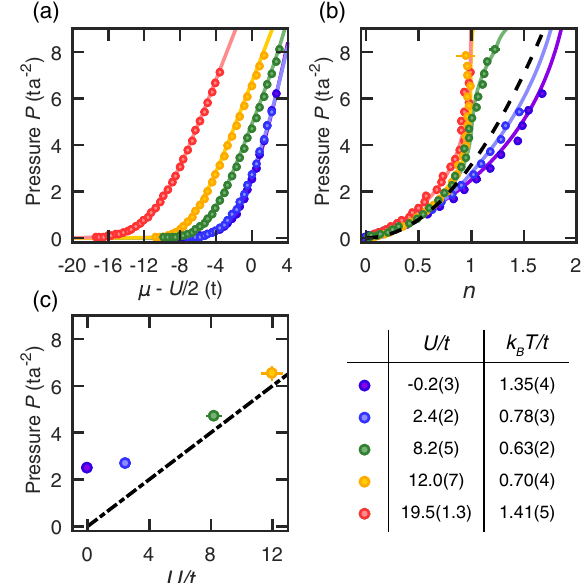
FIG. 1. Pressure as a function of interaction strength and temperature. (a) Pressure versus chemical potential for different interaction strengths and temperatures. The uncertainties of the pressure and the chemical potential are smaller or equal to the marker size. (b) Pressure versus filling for the same interactions and the same temperatures as in (a). Horizontal error bars display the standard error obtained from averaging the density data over regions of constant chemical potential. The solid lines in (a) and (b) are the predictions from NLCE data [21] with the exception of the purple solid line, which represents the ideal Fermi gas on a lattice; the black, dashed line in (b) is the T ¼ 0 prediction of the free Fermi gas using the effective mass at the bottom of the lowest band. (c) Pressure at half filling n ¼ 1 versus interaction strength. The horizontal error bars display the systematic uncertainties of U=t , the vertical error bars indicate the uncertainty of determining half filling from the density profiles n ð μ Þ . The dash-dotted line is the infinite- U and zero-temperature prediction P ¼ U= ð 2 a 2 Þ